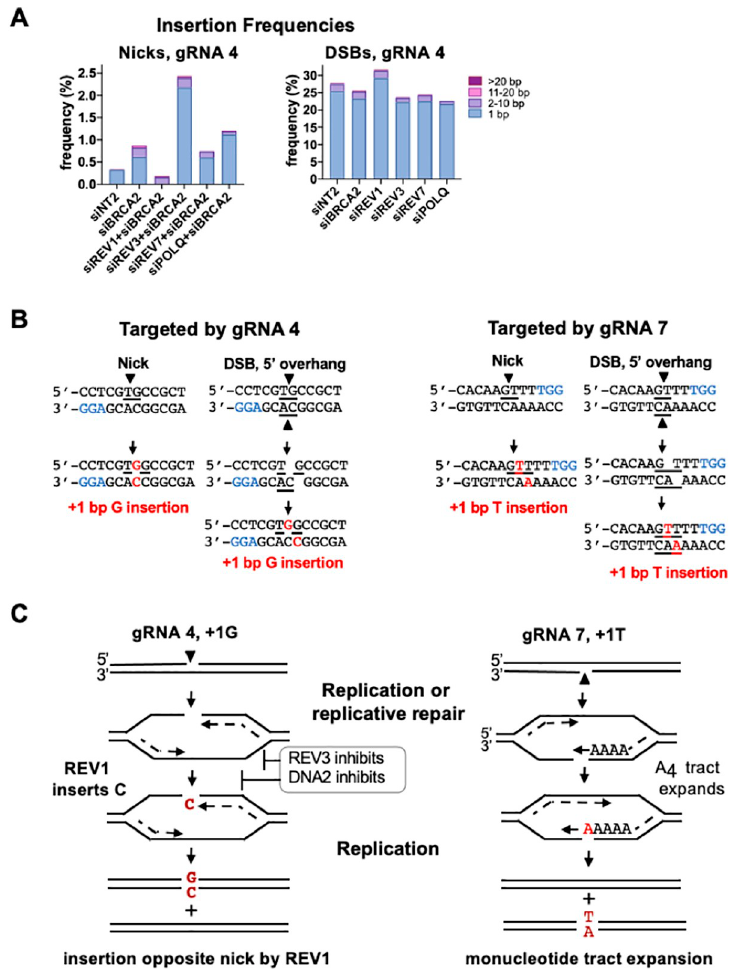
Fig 6. 1 bp insertions at nicks targeted by gRNAs 4 and 7. (A) Effects of depletion of indicated factors on frequencies of insertions of indicated lengths at nicks and DSBs targeted by gRNA 4 to the CD44 gene in U2OS cells, as determined by amplicon sequencing. (B) Above, the 12 bp region surrounding the gRNA 4 (left) or gRNA 7 (right) target sites at nicks or DSBs (underlined, and strand or strands predicted to undergo cleavage indicated by arrowheads); PAM, blue font. Below, sequence changes due to 1 bp insertions at nicks or DSBs bearing 5’ overhangs, red font. For DSBs, the intermediate carrying 5’ overhangs is shown for clarity. These and other sequences shown illustrate the top DNA strand, which is the strand targeted for nicks by gRNA 4/Cas9D10A ( S1 Fig ). (C) Left, diagram of how REV1 may insert C opposite a nick targeted by gRNA 4 during replicative repair or replication, which templates addition of G on the opposite strand. Right, diagram of how replication slippage may expand the mononucleotide tract adjacent to the nick targeted by gRNA 7 from 4 to 5 nt. Following replication or mismatch repair, these will be scored as +1C and +1T insertions at the gRNA 4 and 7 sites,